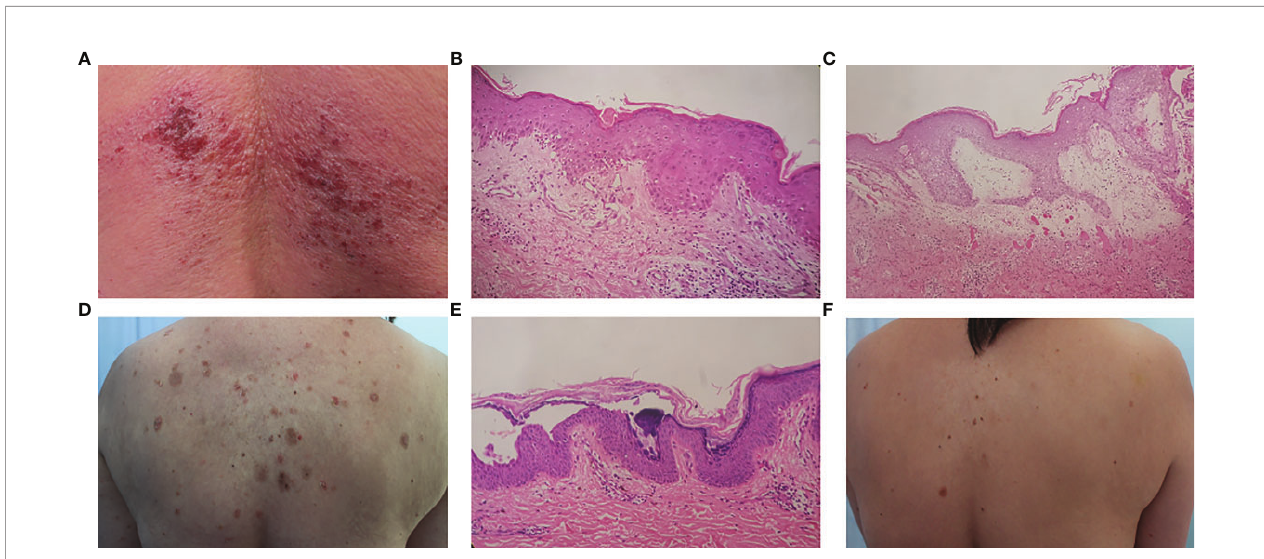
FIGURE 1 | (A) Erythema and vesicles formation on the lower back. (B) Histology from an erythema on the upper back showed focal parakeratosis of the epidermis, liquefaction of basal cells, edema of dermal papilla, and mild super fi cial and middle perivascular lymphocyte in fi ltration. (C) Histology from a vesicle on the lower back showed severe edema of dermal papilla and perivascular lymphocyte in fi ltration. (D) Multiple ruptured bullae and erosions on the back. (E) Histological examination from a bulla on the abdomen showed acantholysis and intraepidermal bulla formation. (F) The patient ’ s condition was stable at the last